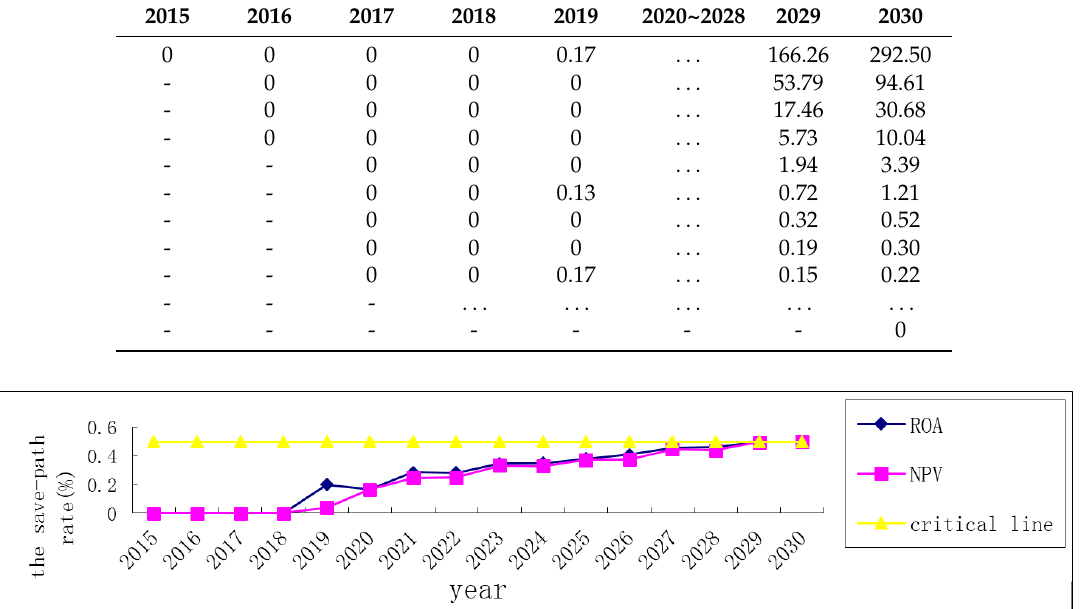
Table 5. Unit decision value of the PV project (real options analysis (ROA)) (yuan/kwh).